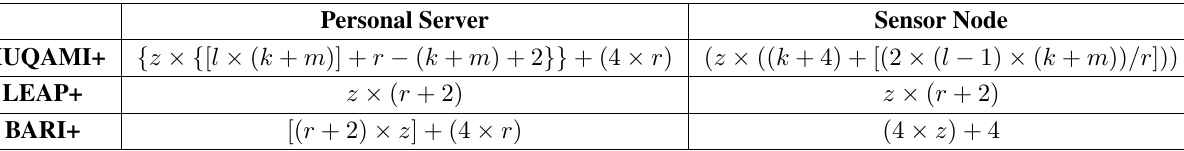
Table 4. Storage requirements (in bytes) of each type of node in all three